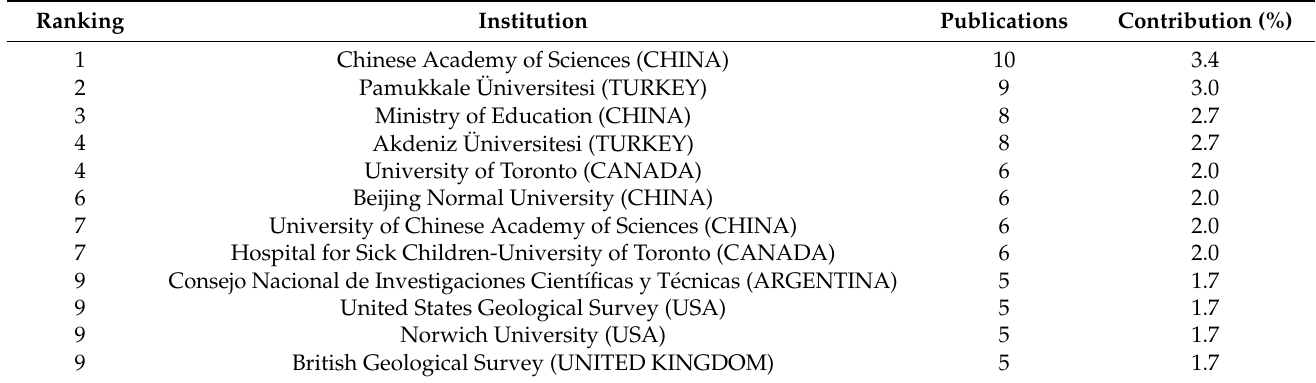
Table 3. The top 12 most productive institutions (at least five